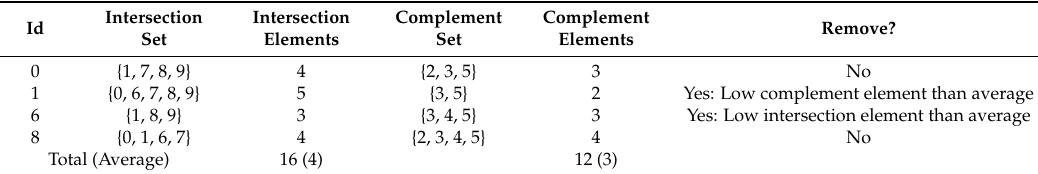
Table 6. Average Filtering